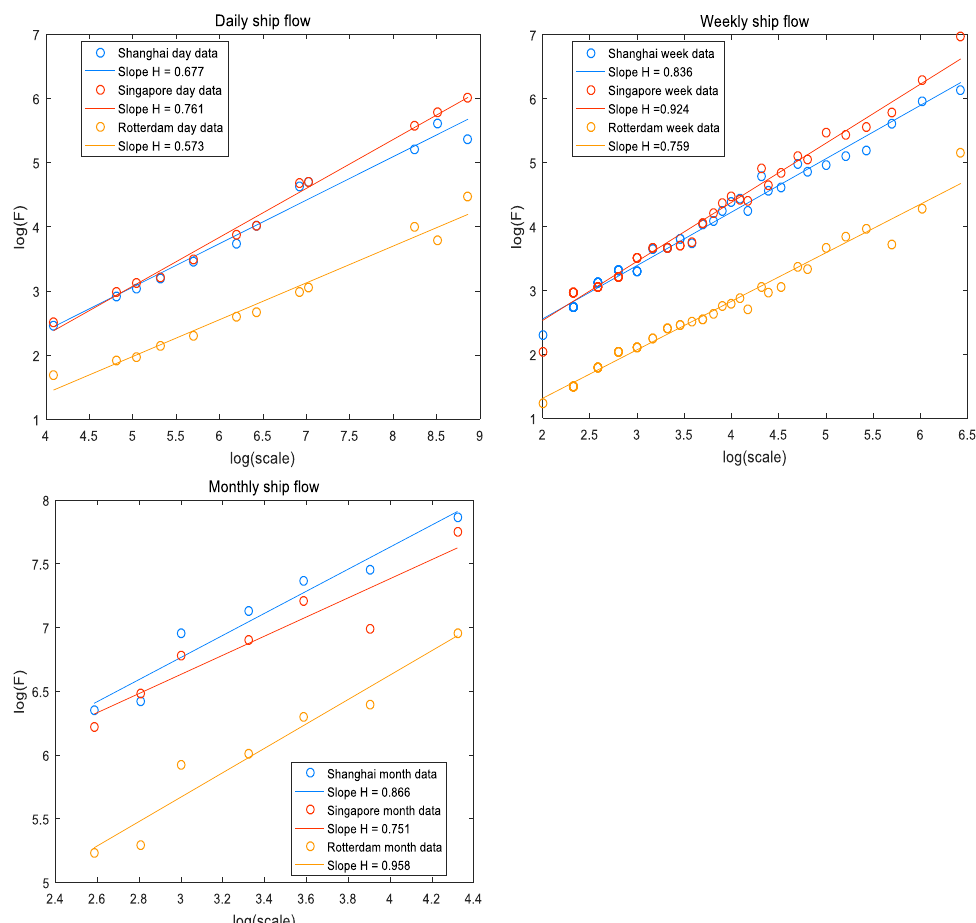
Figure 5. Generalized Hurst exponent ( q = 2 ) for three ports with different time scales.